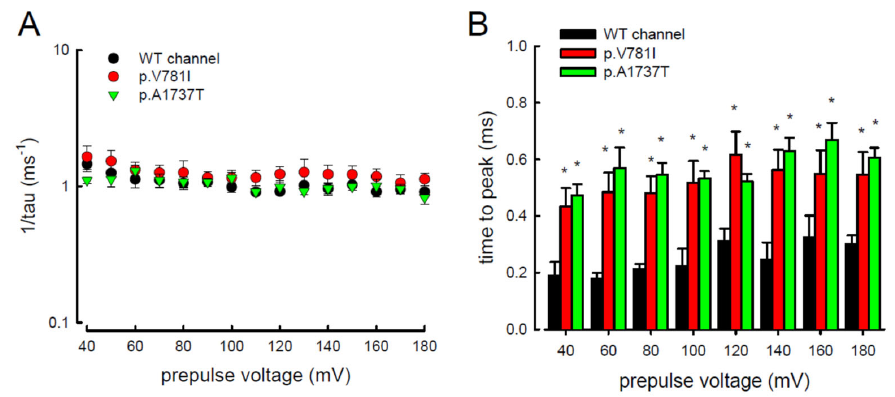
Figure 6. The kinetics of decay and the time for activation of resurgent Na + currents in the WT, p.V781I, and p.A1737T channels. ( A ) The reciprocal of decay time constants (1/tau) of the resurgent Na + currents obtained at − 60 mV after the depolarizing prepulse between +40 and +180 mV in 20 mV increments for approximately 10 ms in the WT and the p.V781I, and p.A1737T mutant channels ( n = 8). ( B ) With different prepulse voltages, the time to peak to generate resurgent Na + current was faster in the WT channel than in the p.V781I and p.A1737T mutant channels. ( n = 8 *; p < 0.05).